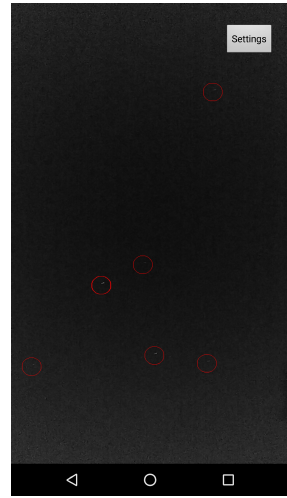
Figure 13. Androidstar-detectionapplication: Thestarsaresurroundedbyredcircles(“BigBear”constellation). This image was captured using a Nexus 5x Android device. The stars are detected in real time (5–10 Hz) in 1080 p (FHD) video resolution. Note that this image contains significant light pollution at the lower side of the